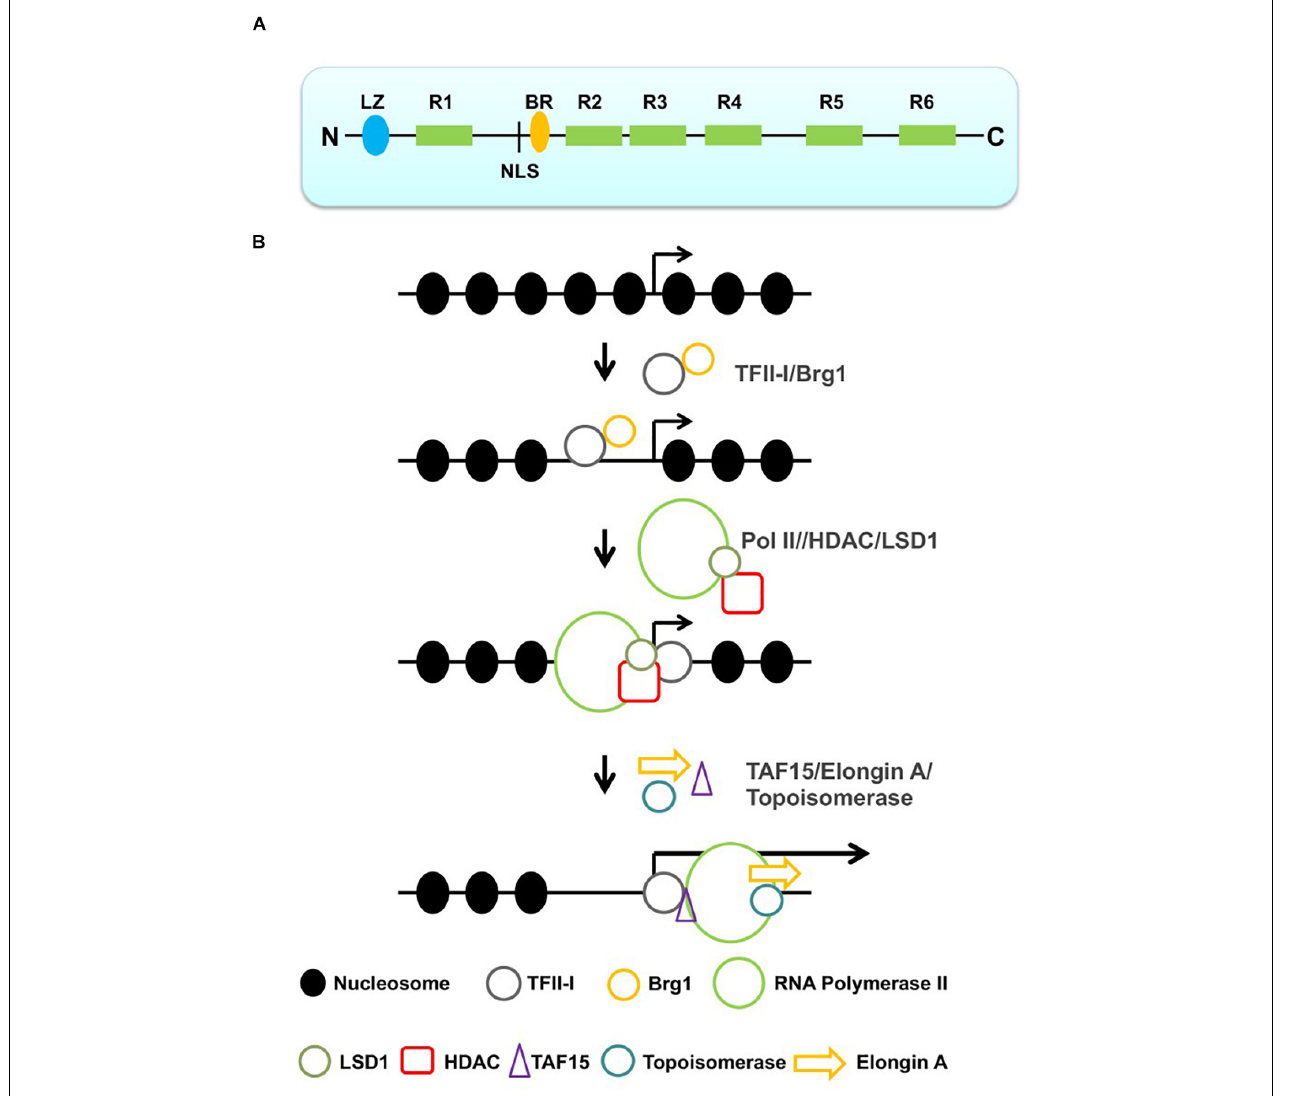
FIGURE 1 | Structure of TFII-I and sequential action of TFII-I leading to the recruitment of a productive Pol II transcription complex. (A) Structure of TFII-I (LZ, leucine zipper; R1–R6, I-repeats; NLS, nuclear localization sequence; BR, basic region). (B) TFII-I interacts with the chromatin remodeler Brg1 and establishes an accessible chromatin configuration at a specific promoter. Interactions with negative co-regulators (HDAC and LSD1) keep the promoter in an accessible but inactive configuration. Dissociation of the negative co-regulators and association with positive transcription elongation factors (TAF15, topoisomerase and Elongin A) converts Pol II into a productive elongation